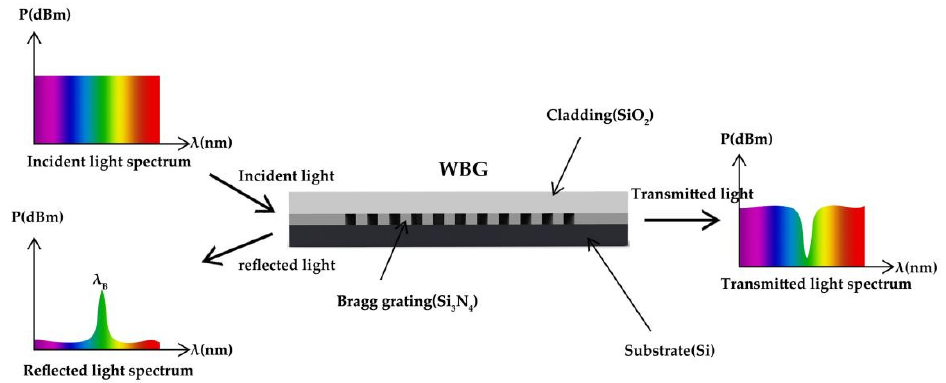
Figure 8. WBG reflection principle.